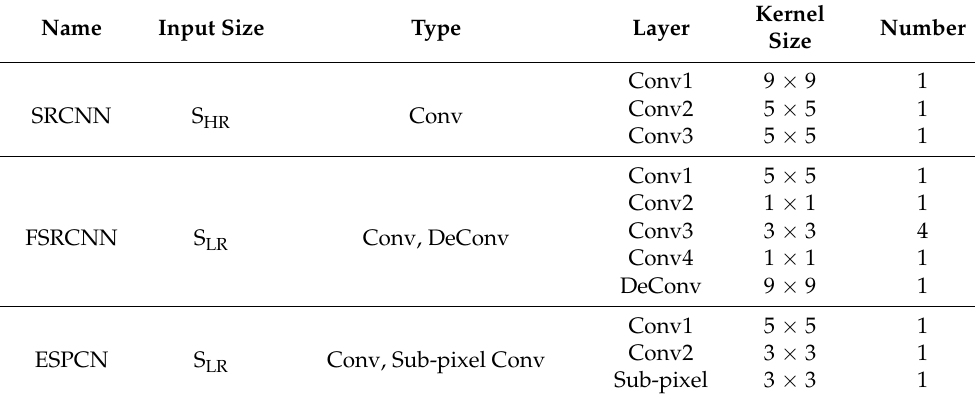
Table A1. ‘Conv’ and ‘DeConv’ refer to the convolutional layer and deconvolutional layer, respec- tively. ‘Sub-pixel Conv’ refers to the sub-pixel convolutional layer. ‘BP stages’ represents a sequence of projection units including up- and down-projection